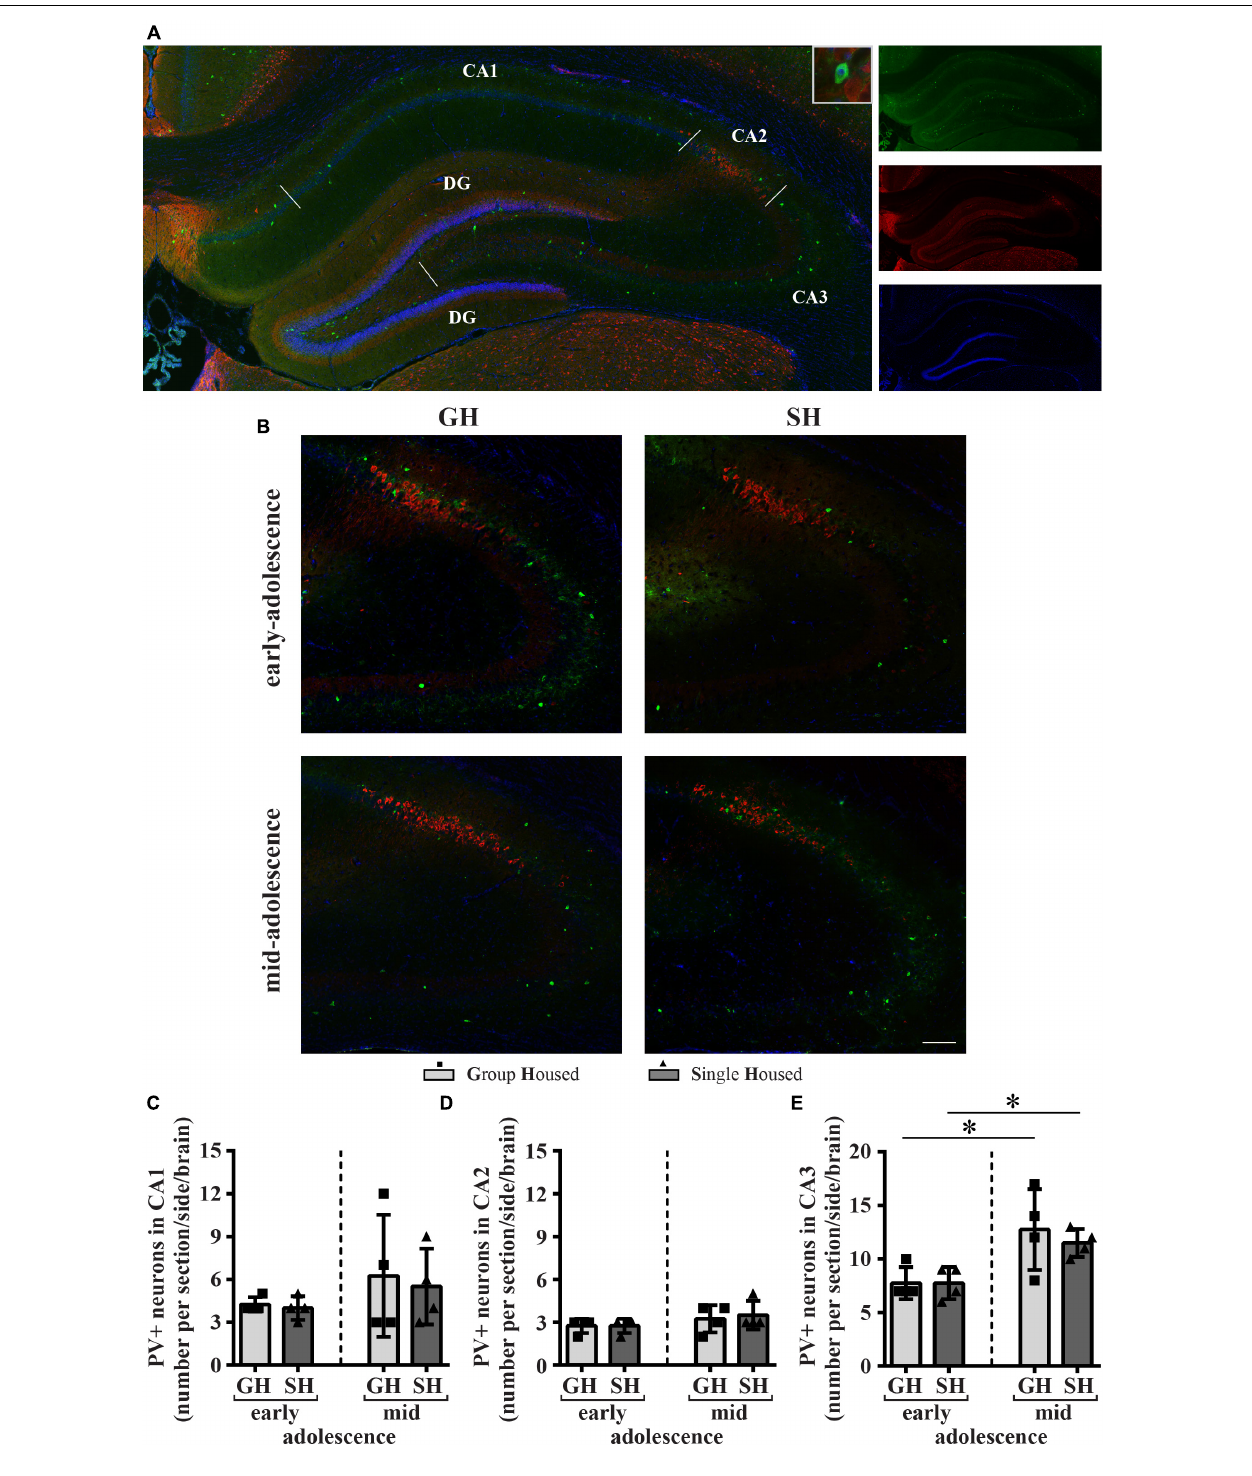
FIGURE 9 | The number of neurons with parvalbumin (PV) immunoreactivity (PVI) in the dorsal hippocampus (the CA1, CA2, and CA3 subfields) of peripubertal rats at the end of the first week (early-adolescence) and the second week (mid-adolescence) of defined housing, which began on the 29th postnatal day. (A) A representative panoramic image of the PVI in the hippocampus of a peripubertal rat. (B) Representative panoramic images for CA2/CA3 subfields. (C–E) The number of PVI-labeled neurons in the CA1, CA2, and CA3 subfields. The dorsal hippocampus was analyzed regarding the adult rat atlas brain (–2.9 to –3.6 mm from the bregma, Paxinos and Watson, 2005). Scale bar 100 µ m. ∗ p ≤ 0.05 (early-adolescence vs. mid-adolescence (maturation) within the same housing conditions). Statistical comparisons and exact p -values are given as Supplementary Table S1 .